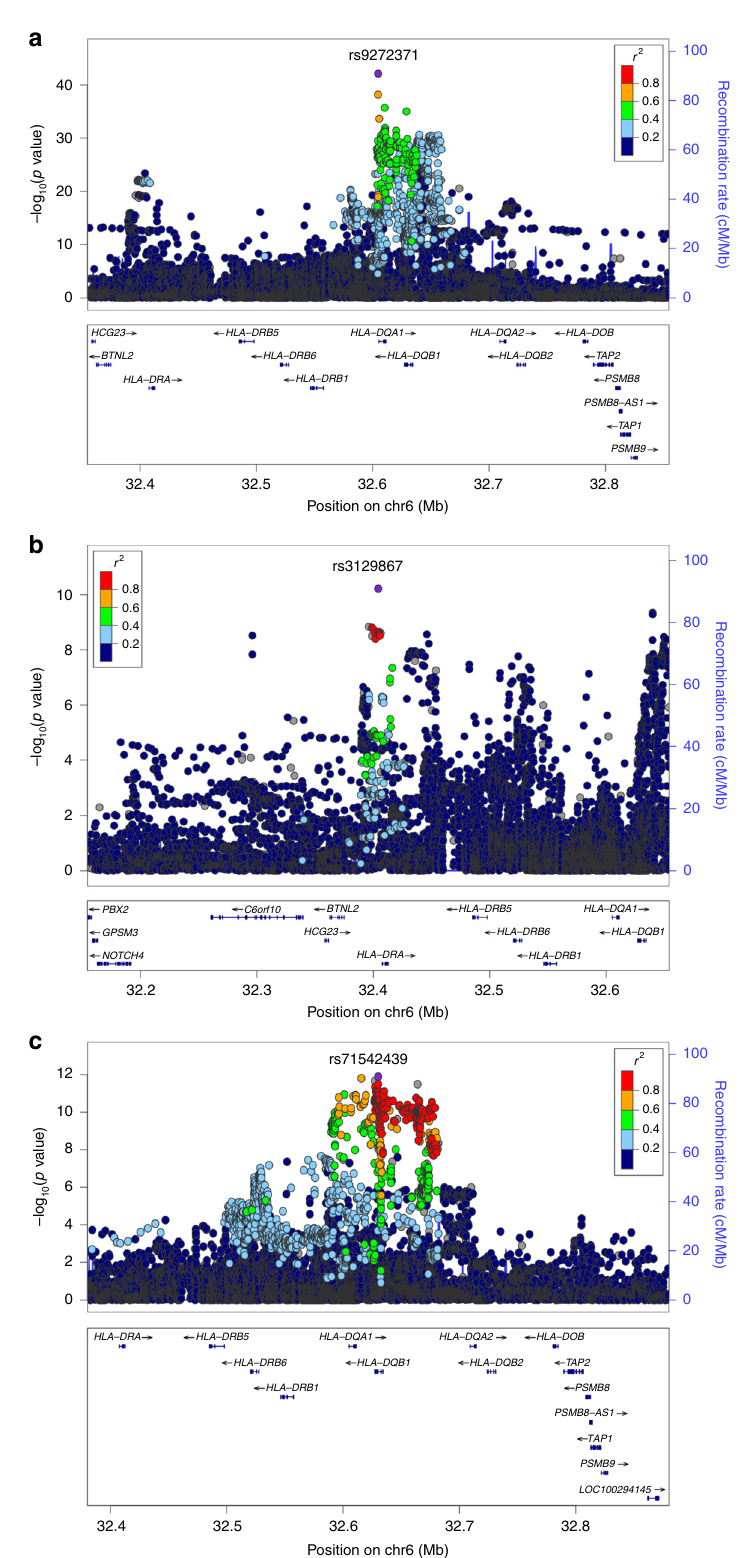
Fig. 5 Regional association plots for lead SNPs associated with anti-EBV IgG levels (p < 1 × 10 − 8 ), n = 4365 individuals. a Lead association on chromosome 6 in HLA-DQA1 with anti-EBNA-1 IgG (rs9272371, p = 3.60 × 10 − 44 ). b Secondary association on chromosome 6 in HLA-DRA with anti- EBNA-1 IgG (rs3129867, p cond = 2.78 × 10 − 11 ). c Lead association on chromosome 6 in the HLA-DQB1 with anti-VCA IgG (rs71542439, p = 1.15 × 10 − 12 ). GWAS performed using linear mixed model accounting for kinship in GEMMA. The lead SNPs are labelled and coloured in purple. LD ( r 2 ) was calculated based on SNP genotypes in